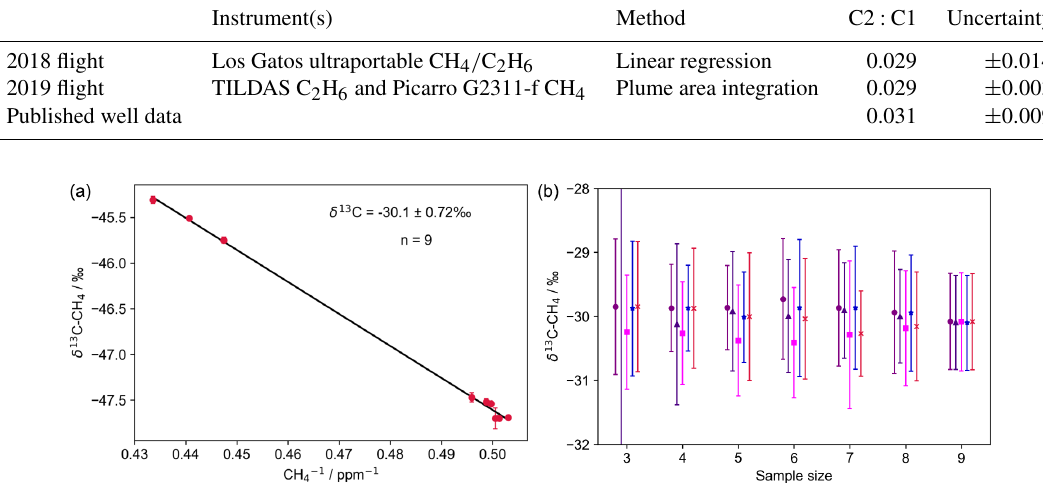
Table 2. Reported data for C2 : C1 for a single installation surveyed during both the 2018 and 2019 surveys. Well data from UK oil and gas authority report are available at https://dataogauthority.blob.core.windows.net/external/DataReleases/ShellExxonMobil/GeochemSNS.